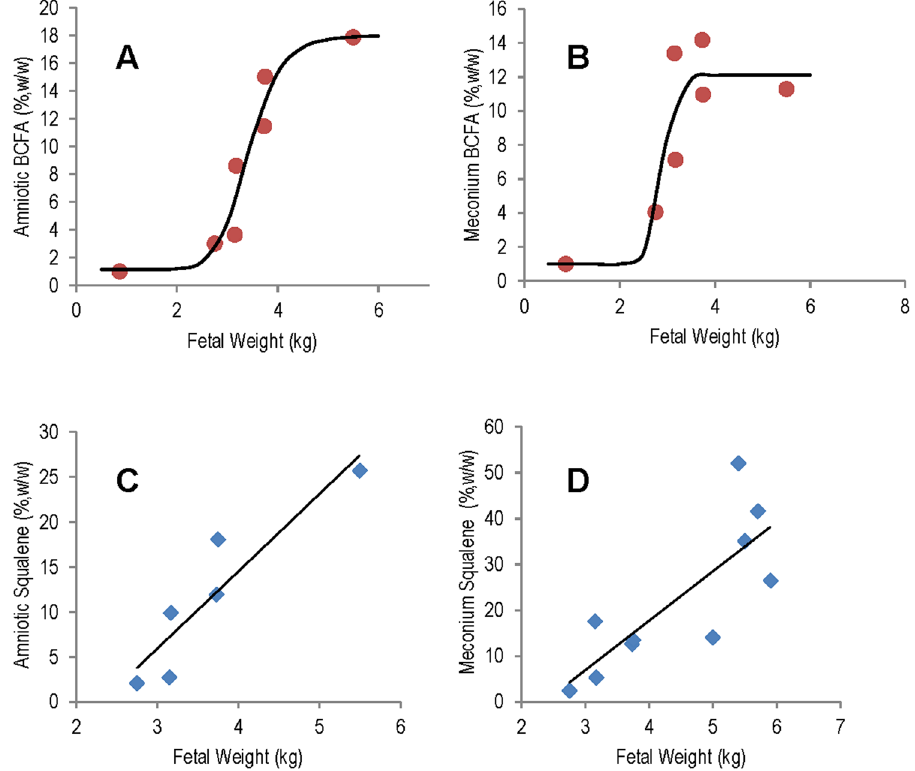
Figure 2. BCFA and squalene in amniotic fluid and meconium increase with gestational weight gain. ( A ) The sigmoidal shapes are consistent with development of vernix in the last half of gestation, as in humans. Meconium only was available from the 0.86 kg early-gestation sea lion fetus and is plotted for amniotic fluid modeling. B = 18.0 + (1.15–18.0)/(1 + (w/3.42) 10.6 ); r 2 = 0.93; p = 0.04. B is total BCFA, and w is fetal weight. ( B ) Meconium BCFA. B = 12.1 + (0.997–12.1)/(1 + (w/2.89) 19.1 ); r 2 = 0.81, p = 0.18. ( C ) Squalene in amniotic fluid shows a linear growth trend. S = 8.59w − 19.8; r 2 = 0.84; p < 0.001. ( D ) Squalene in meconium. S = 10.8w − 25.4; r 2 = 0.64; p <